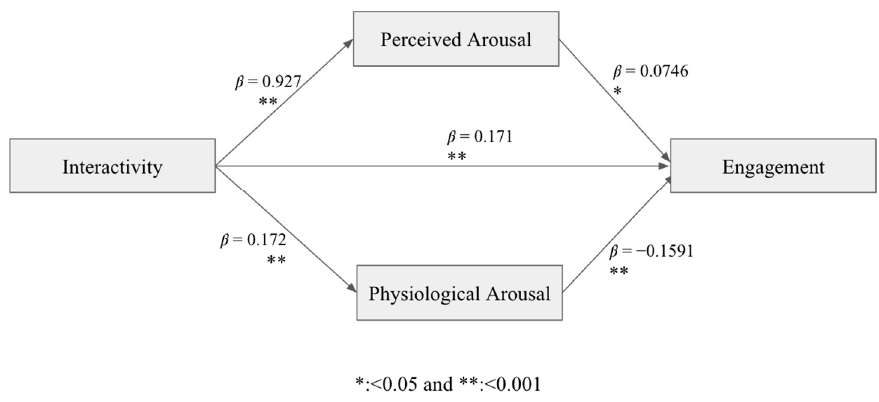
Figure 6. Visual Representation of our